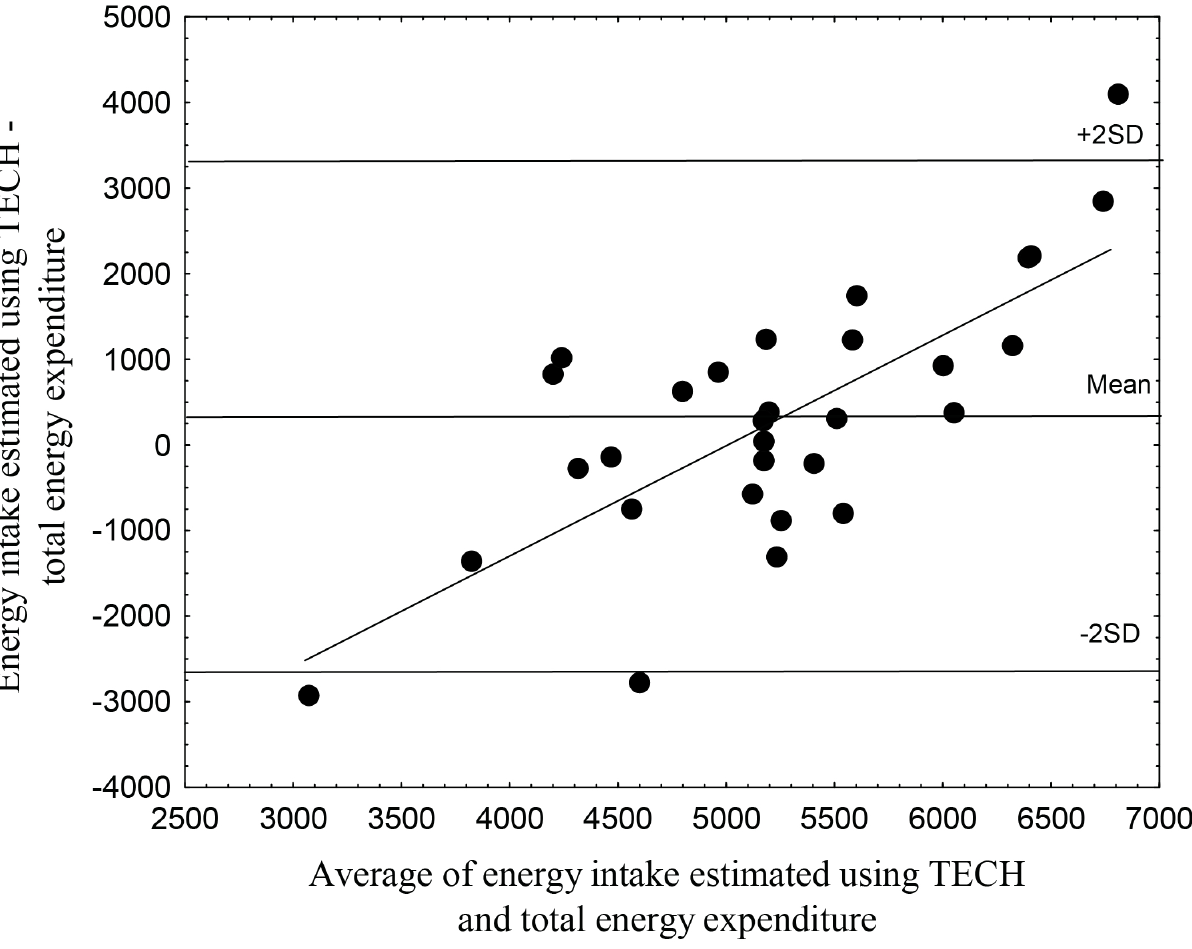
Figure 3. A Bland-Altman plot comparing energy intake estimated using TECH and total energy expenditure measured using the doubly labeled water method in 30 healthy 3 year old children. The mean difference between the methods was 330 kJ/24h with limits of agreement (2SD) of 2990